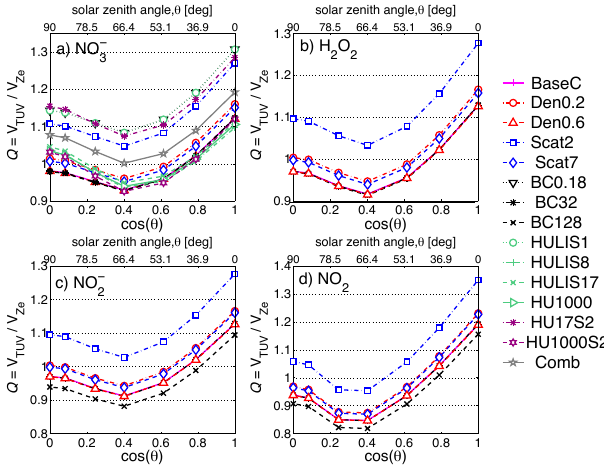
Figure 3. The ratio of depth-integrated photolysis rate coefficient, Q = v TUV , for the two different methods as a function of solar v z e zenith angle, θ . (a) NO − anion; (b) H 2 O 2 ; (c) NO − anion; (d) NO 2 . 3 2 Magenta: BaseC snowpack ( ρ = 0.4gcm − 3 , [BC] = 4ng ( C ) g − 1 and σ scatt = 25m 2 kg − 1 ).